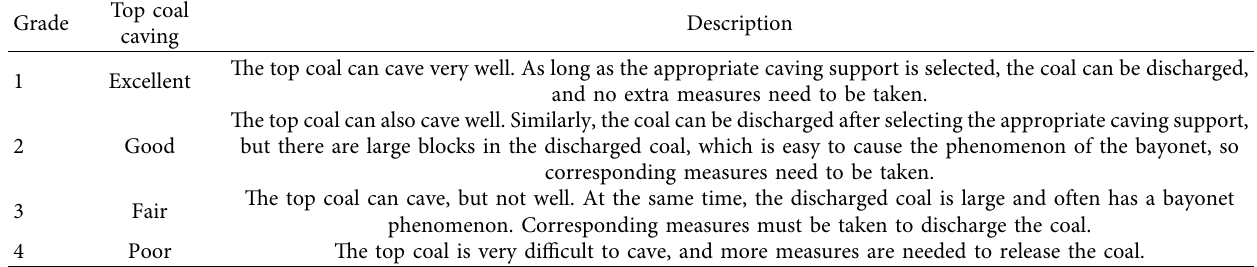
Table 1: Caving grade of top coal.